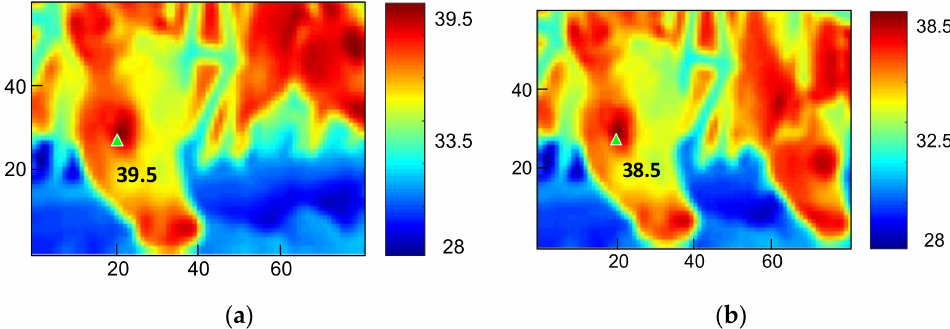
Figure 6. The effect of wind speed on IRT. ( a ) The lacrimal gland temperature is 39.5 ◦ C in the absence of wind. ( b ) The lacrimal gland temperature is 38.5 ◦ C at wind speed of 0.6 m/s.